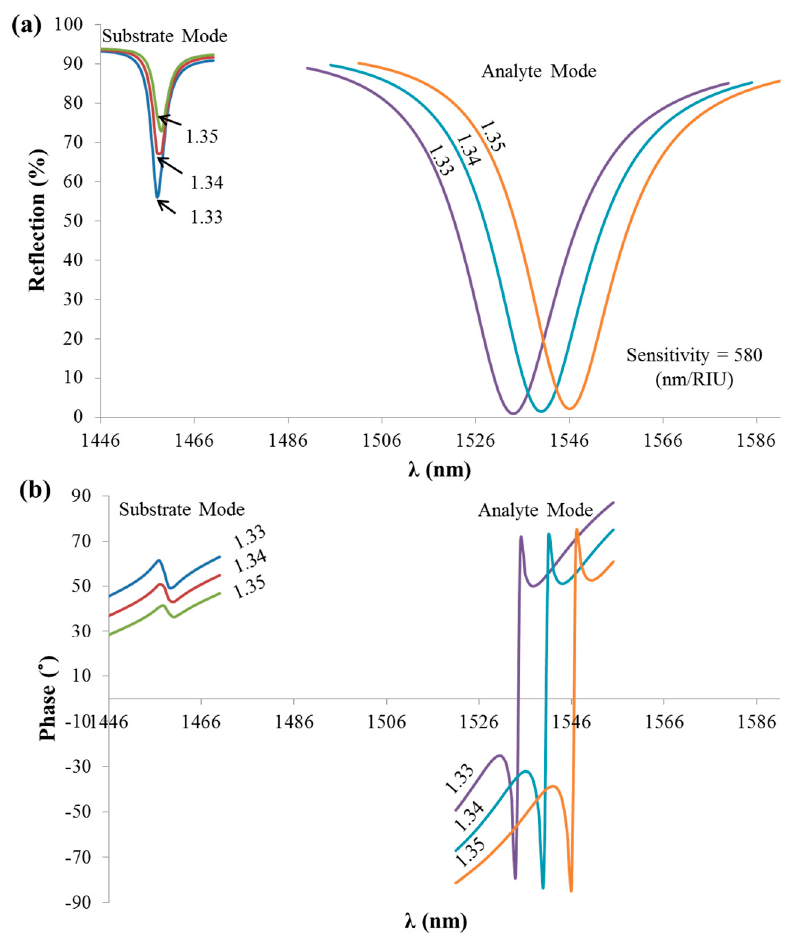
Figure 7. ( a ) Reflection spectra from the TDGTMF geometry at different analyte RIs. ( b ) Phase response at the same RIs as in Figure 7a. TM-polarized light under normal incidence was used in the simulations of the Si3N4 grating, with Λ = 1000 nm and FF = 0.55. SiO 2 was used for the substrate.